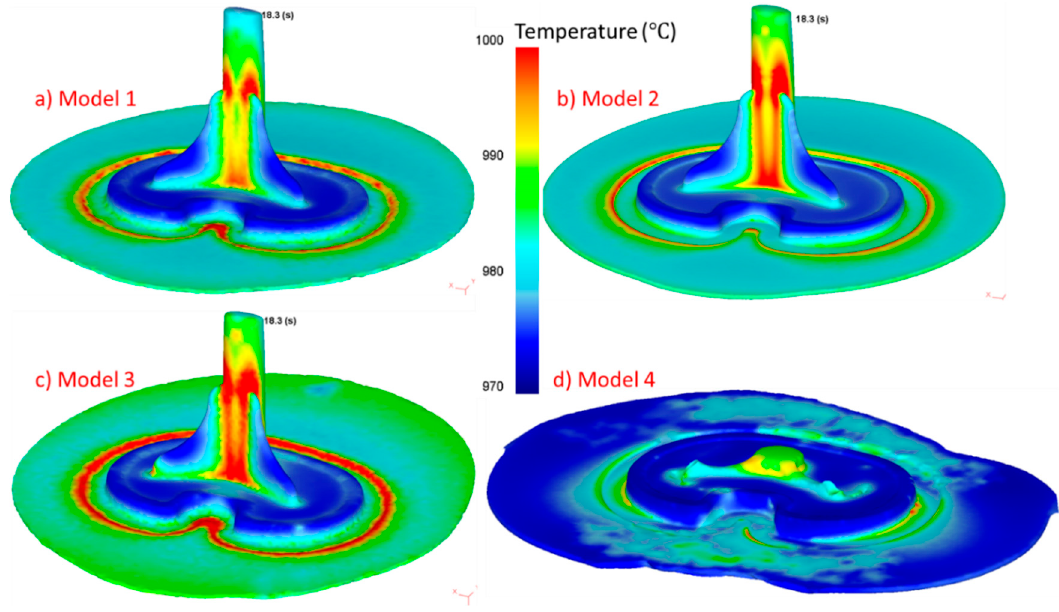
Figure 5. Thermal field displayed over the forging for ( a ) Model 1, ( b ) Model 2, ( c ) Model 3, and ( d ) Model 4, at the same time-frame through the forging process.